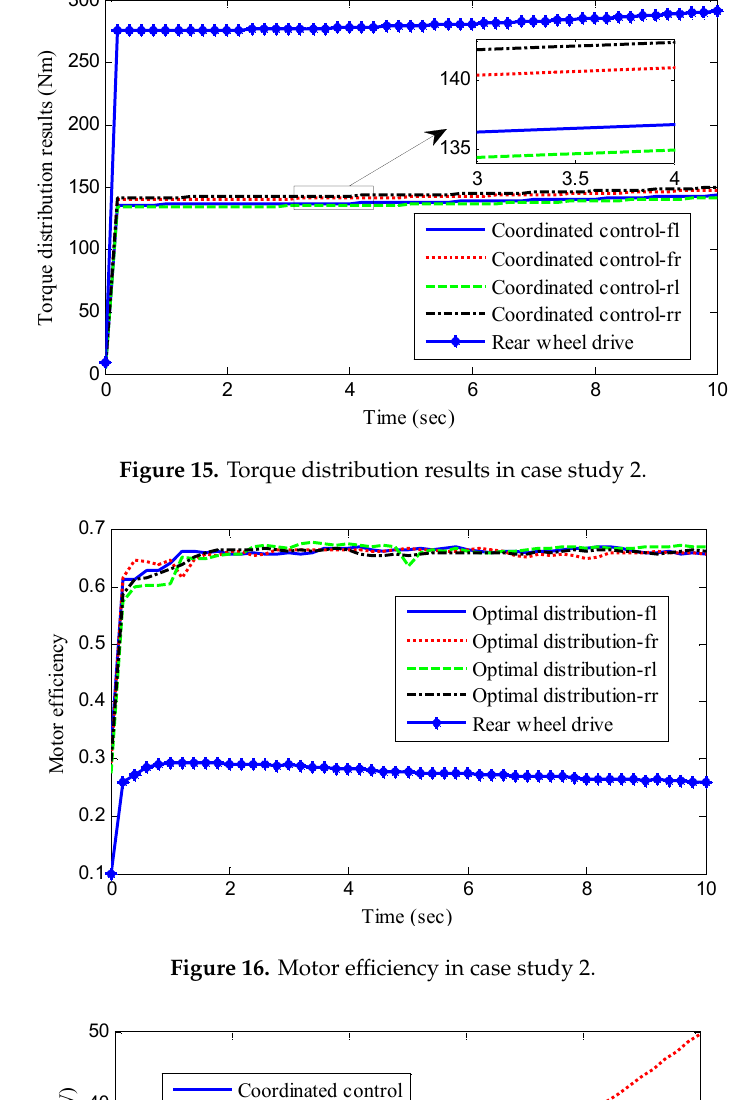
Figure 14. Torque demand in case study 2.